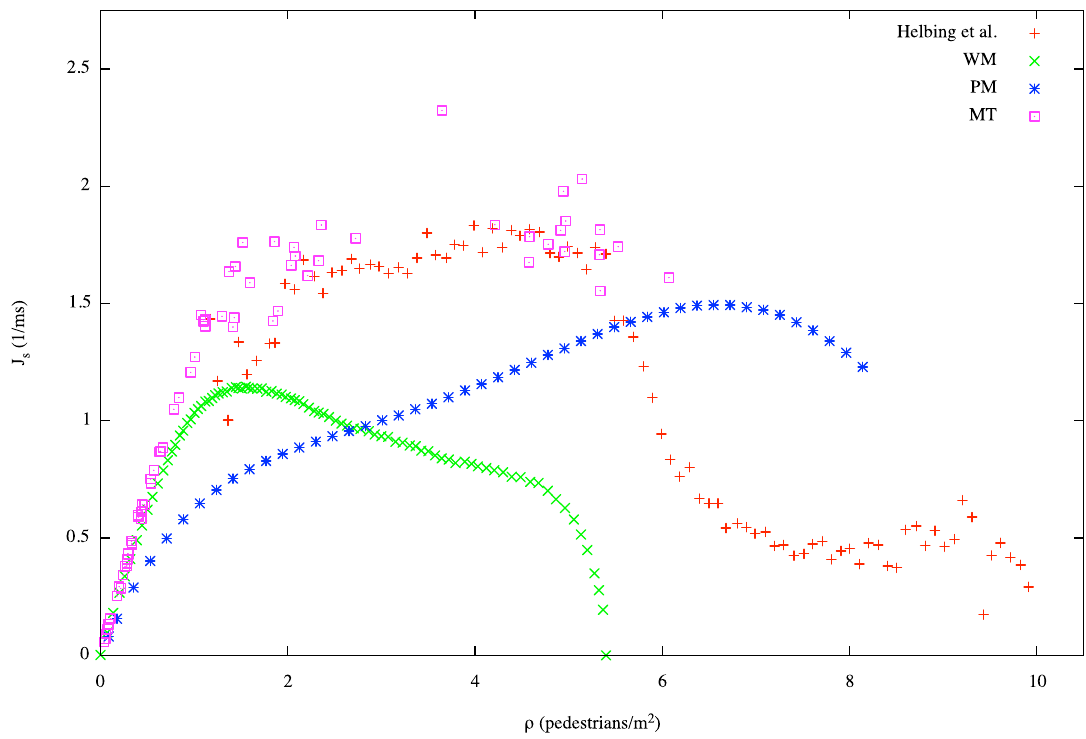
Figure 6. Empirical fundamental diagrams for pedestrian movement in planar facilities as reported by design manuals design manuals [50,51] and also data points related to experimental measurements (respectively carried out in the context of the Hajj in Saudi Arabia by Helbing [52] and in the city of Osaka, in Japan, by